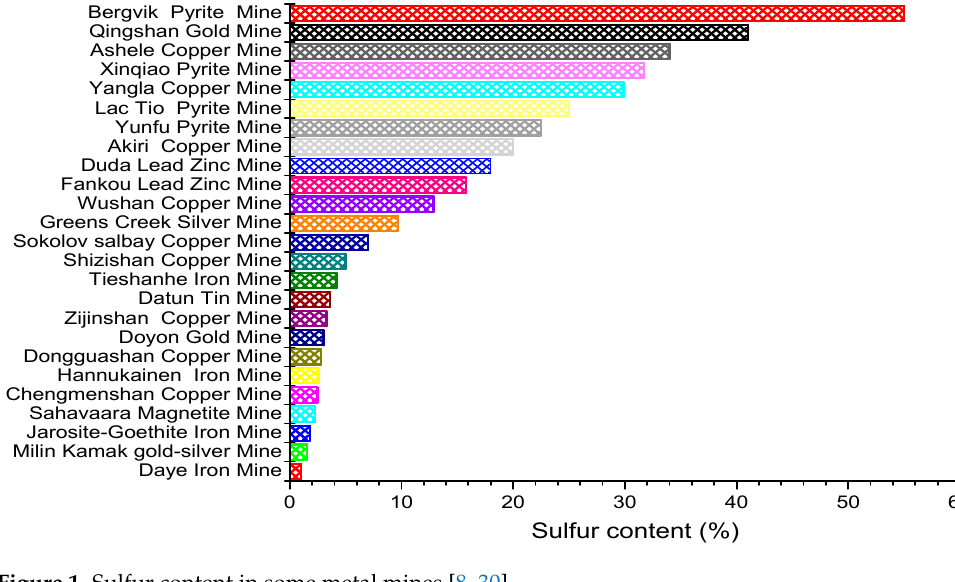
Figure 1. Sulfur content in some metal mines [8–30].